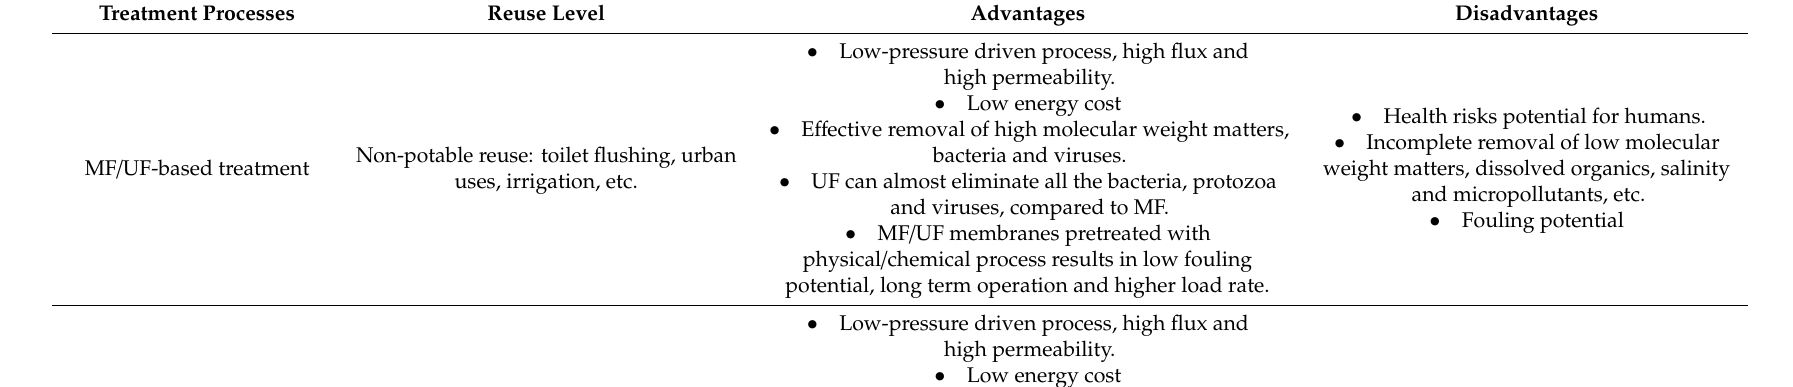
Table 14. Advantages and disadvantages of various membrane-based treatment